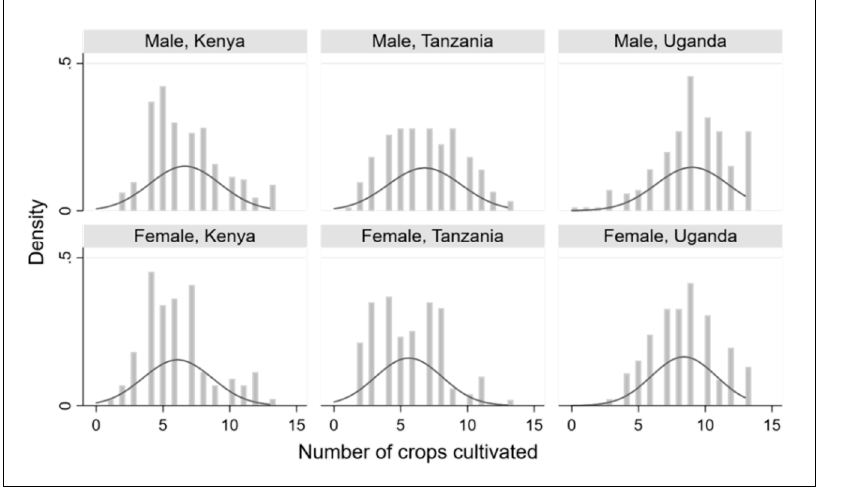
Figure 2. Number of Crops Grown by Sample